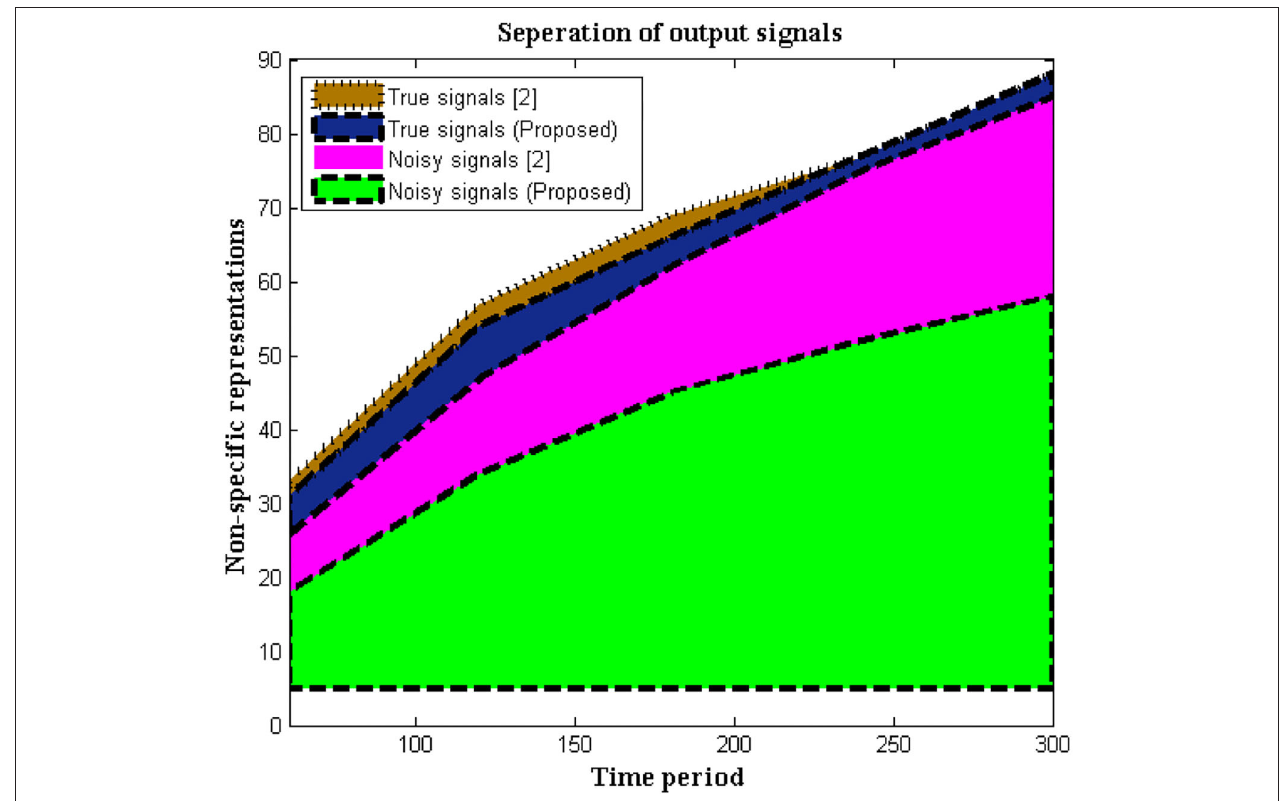
FIGURE 2 | Representation of recorded